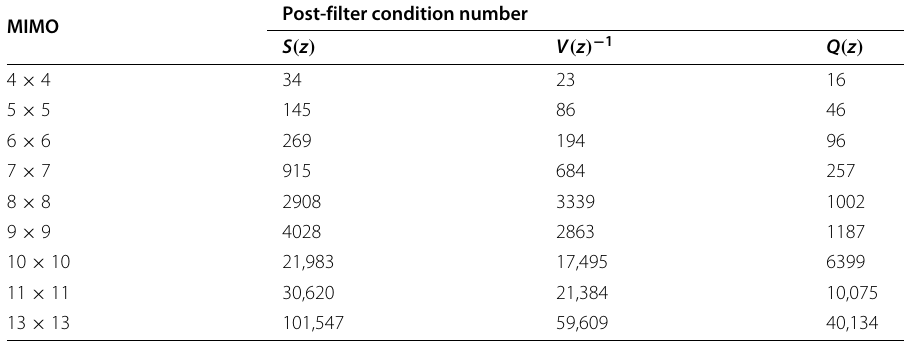
Table 2 Comparison of condition numbers: row balancing schemes, left-right swapping, and combination of both Post-filter condition number MIMO